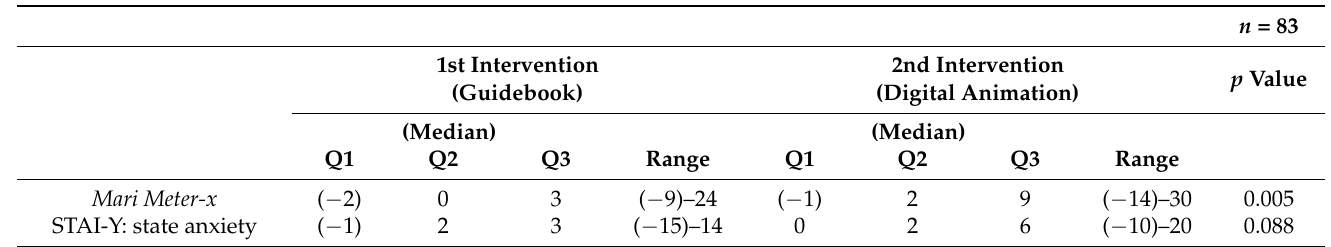
Table 3. Outcomes for the 1st intervention vs. the 2nd intervention.